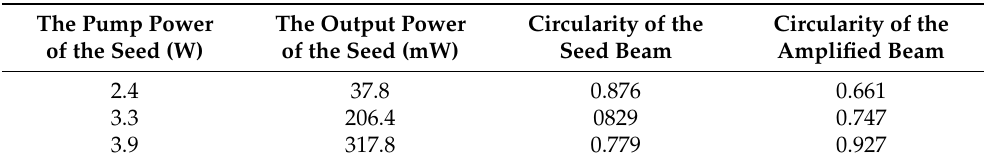
Table 1. The circularity of the amplified beam with a pumped power of 7 W versus different pump powers of the seed.